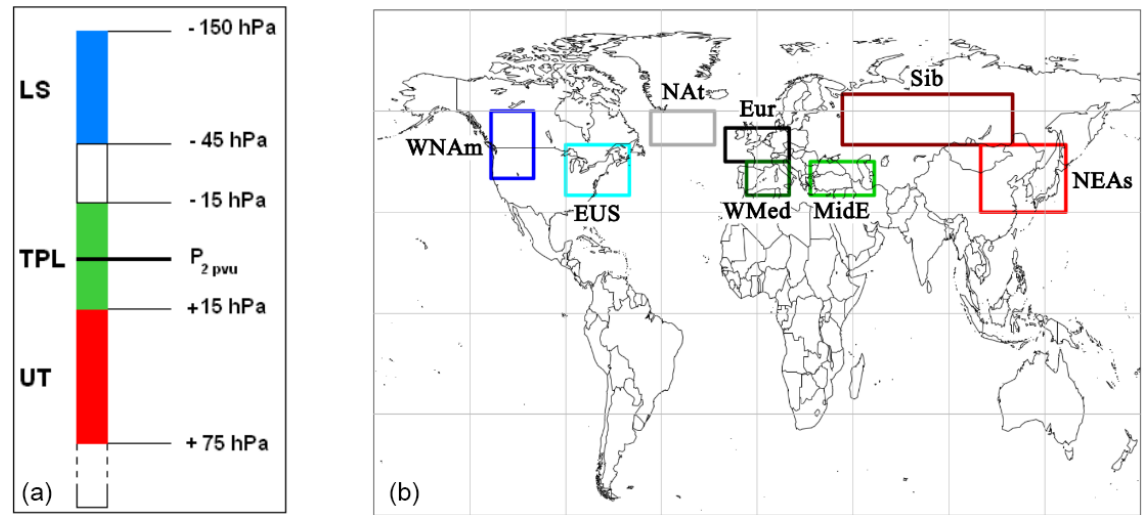
Figure 1. (a) Schematic representation of the definition of the upper troposphere (UT), tropopause layer (TPL), and lower stratosphere (LS) in red, green, and blue respectively. The pressure levels are indicated on the right, relatively to the PV isosurface ( P 2pvu ). (b) Map of the regions compared in this study. From west to east: western North America (WNAm), the eastern United States (EUS), the North Atlantic (NAt), Europe (Eur), the Western Mediterranean basin (WMed), the Middle East (MidE), Siberia (Sib), and northeastern Asia